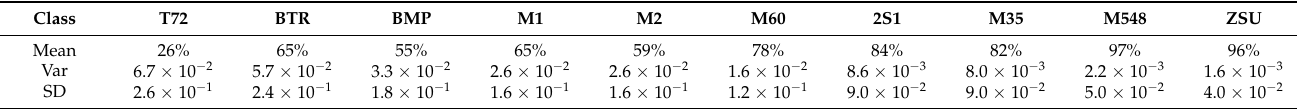
Table 3. SAR-only simple net intraclass variance (Var) and standard deviation (SD).